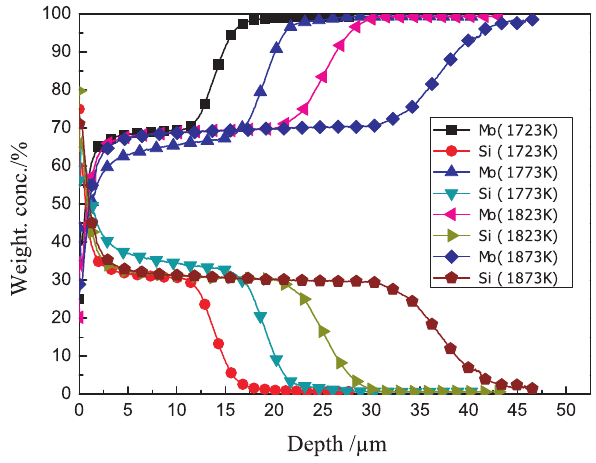
Fig. 2: The silicon molybdenum content distribution for Mo-MoSi 2 functionally graded coating prepared at 1723 ∼ 1873 K for 20 min